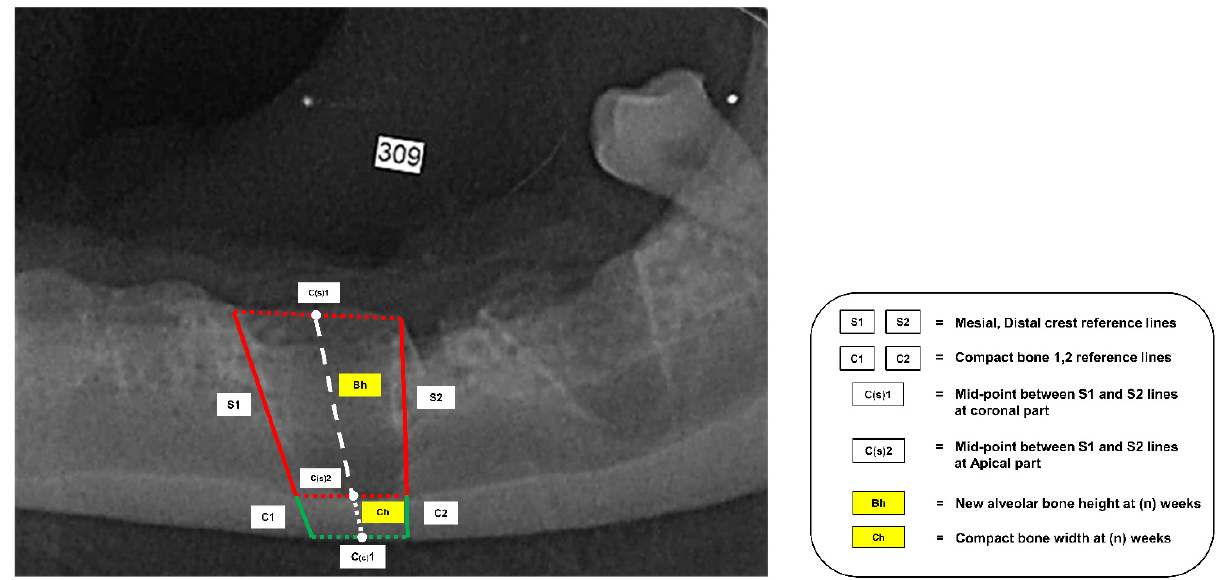
Figure 4. Intra-oral radiograph schematic with reference lines for bone height measurement in post-extraction socket using Vet Exam program.